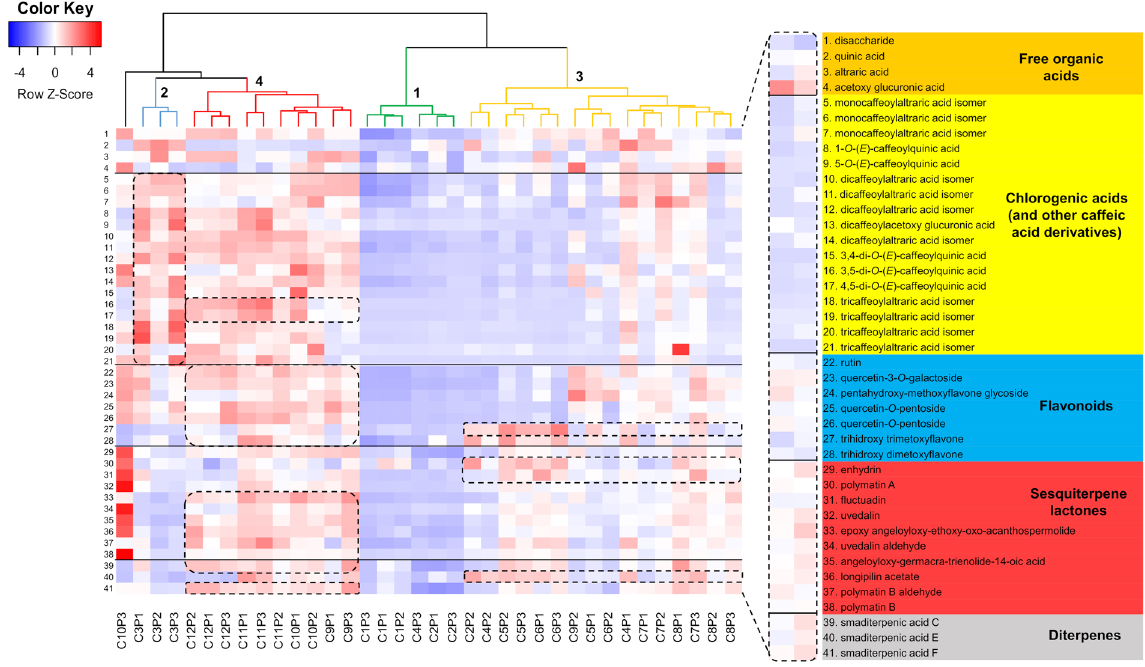
Figure 3. Heatmap showing the differential accumulation of 41 metabolites in 36 extracts from Smallanthus sonchifolius analyzed by UHPLC-UV-HRMS. Dash boxes highlight the preferential accumulation of metabolites by the four different groups of samples.